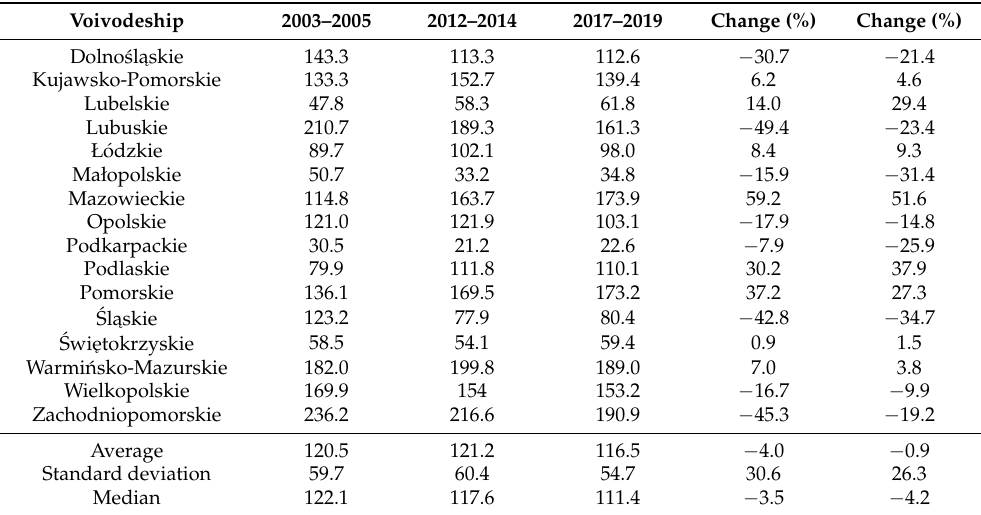
Table 3. Distribution dynamics of the gross value added per person working in relation to the country 1,2